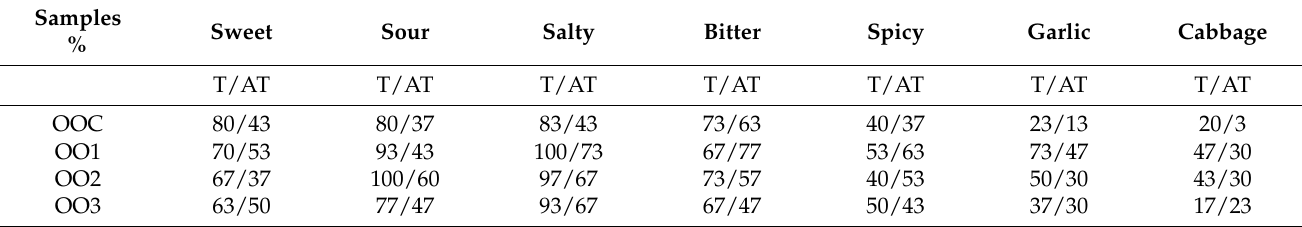
Table 5. The percentage of terms used to describe the taste (T) and aftertaste (AT) of the experimental samples with olive oil.